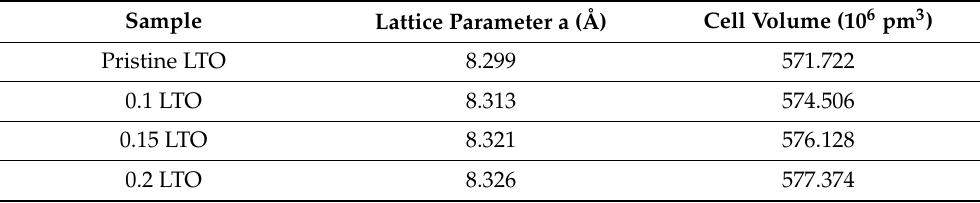
Table 1. Lattice parameter and cell volume of pristine and iodide-doped LTO.